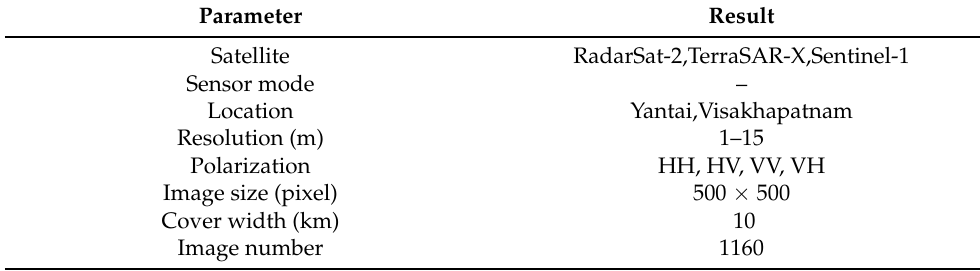
Table 2. Details of the